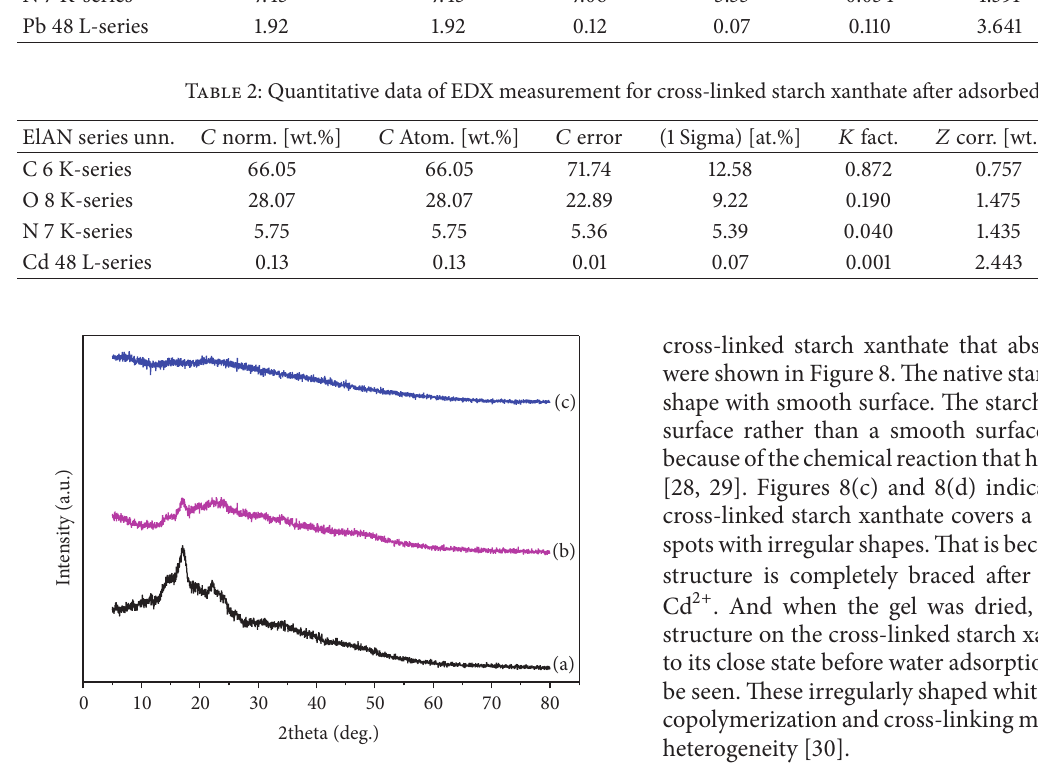
Figure 7: The X-ray diffractogram of native starch (a), starch xanthate, (b) and cross-liked starch xanthate